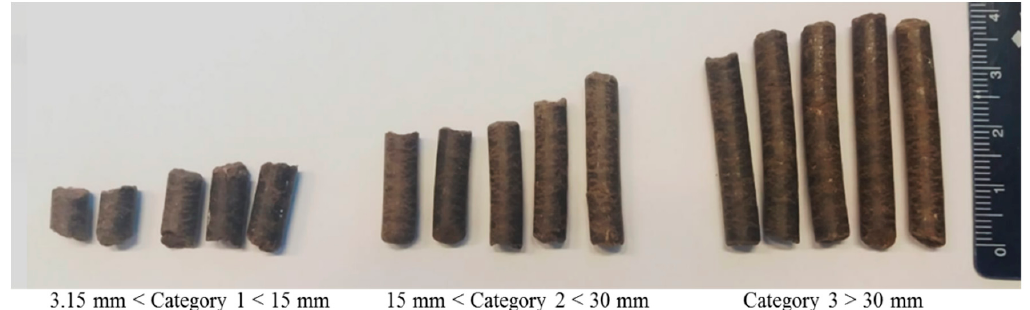
Figure 1. Samples of different categories of torrefied mixed wood pellets.